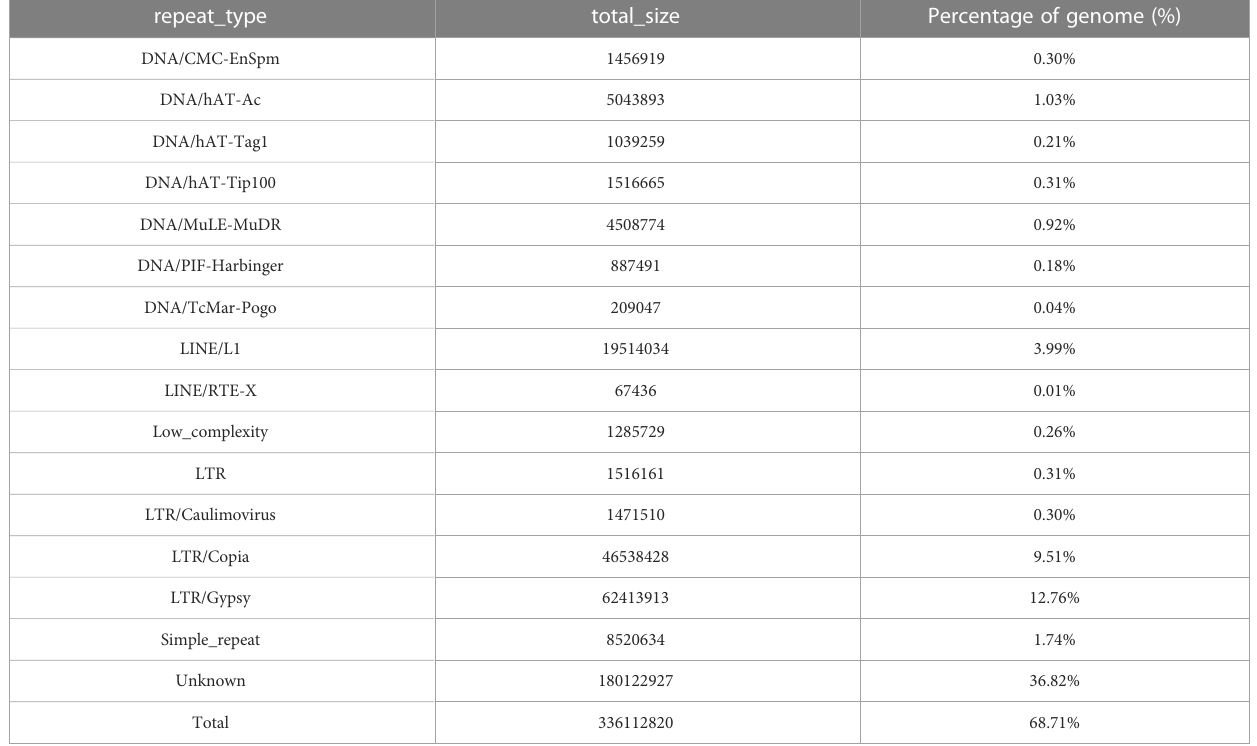
TABLE 3 Repeat elements of the XsoG11 yellowhorn genome.